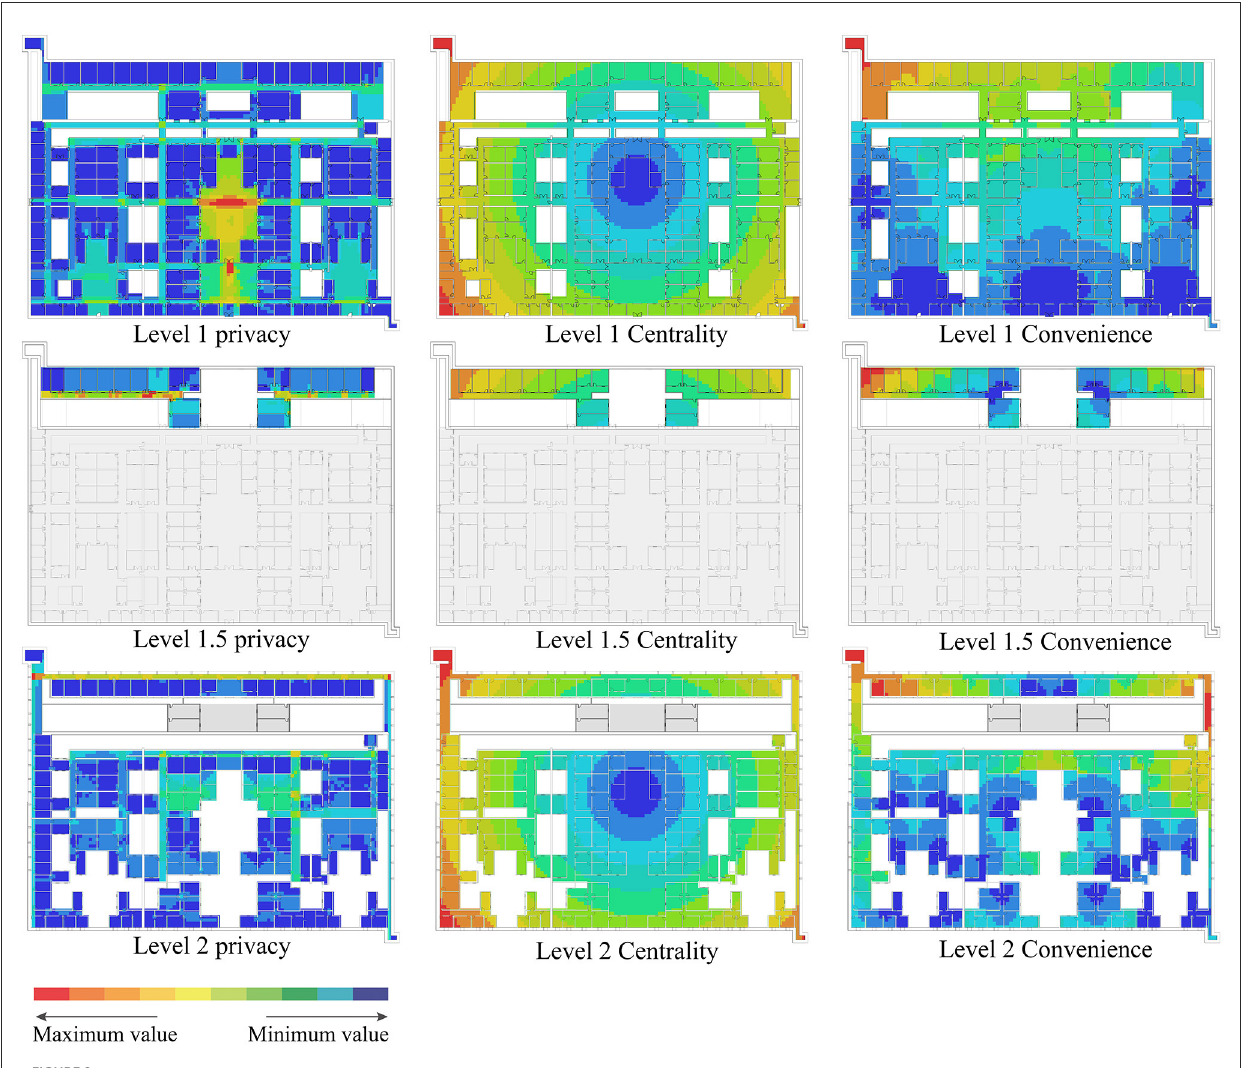
FIGURE9 Overall spatial indicator analysis chart.